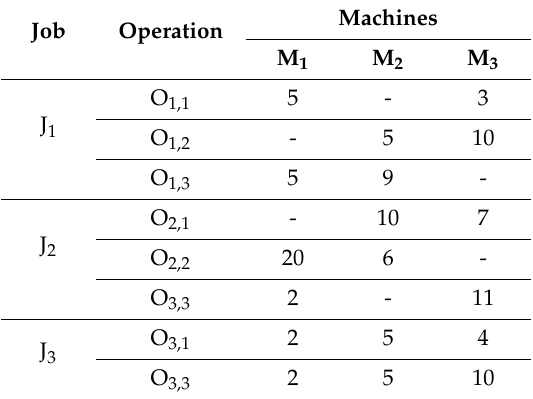
Table 1. Example of flexible job shop scheduling problem pattern.